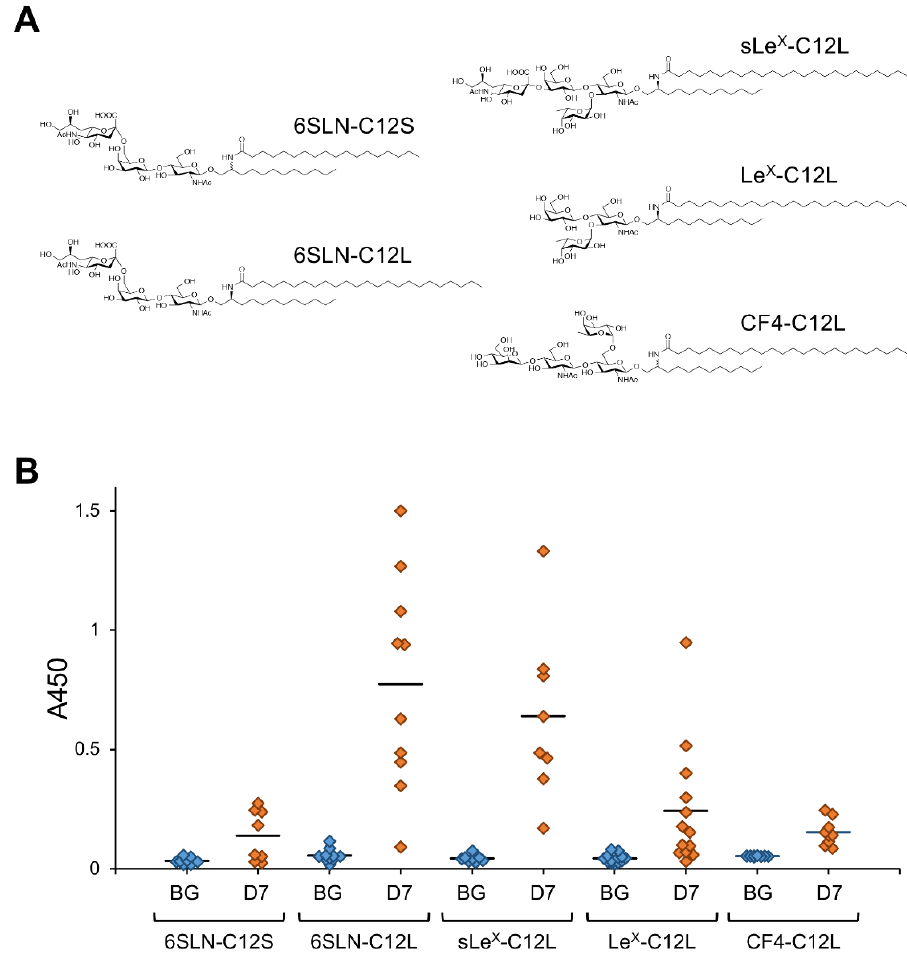
Figure 3. Antibody-inducing activity of artificially synthesized GSLs (artGSLs). ( A ) Chemical structures of artGSLs used for immunization experiments. The ceramide mimetics C12S and C12L are composed of a saturated C12-sphingosine mimetic and stearic acid (C18:0) or lignoceric acid (C24:0), respectively. These ceramide mimetics are bound to the oligosaccharide via a β-linkage. Abbreviations: 6SLN, 6′-sialyl LacNAc/Neu5Acα2,6Galβ1,4GlcNAc; sLe X , sialyl Lewis X /Neu5Acα2,3Galβ1,4(Fucα1,3)GlcNAc; Le X , Lewis X /Galβ1,4(Fucα1,3)GlcNAc; CF4, core- fucosylated tetrasaccharide/Manβ1,4GlcNAcβ1,4(Fucα1,6)GlcNAc. ( B ) Reactivity of mice serum IgMs against immunizing GSL. Mice were immunized with each artGSL, and serum samples were prepared 7 days after immunization, as described previously [15]. Reactivity of serum antibodies